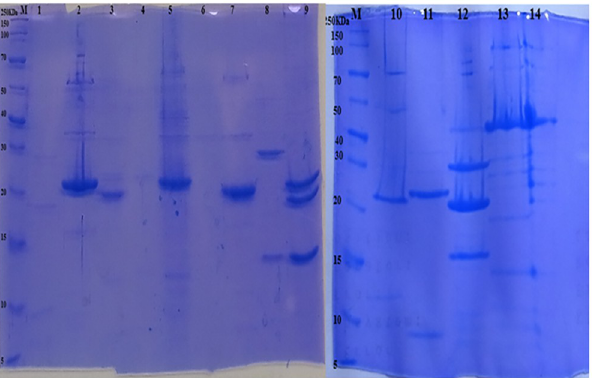
Fig 3. SDS-polyacrylamide gel electrophoretic profiles of phage structural proteins. (M) broad range Page Ruler protein molecular weight marker (Thermoscientific), (1) vB_BpsM-61, (2) vB_EauM-23, (3) vB_EauS-123, (4) vB_BboS-125, (5) vB_BhoP-126, (6) vB_BhoP-126, (7) vB_EalM-132, (8) vB_BcoS-136, (9) vB_EalM-137, (10) vB_BpsS-140, (11) vB_BhaS-171, (12) vB_BpsS-36, (13) vB_VmeM-32, (14) vB_VmeM-196, Numbers to the left indicate band size in kDa.